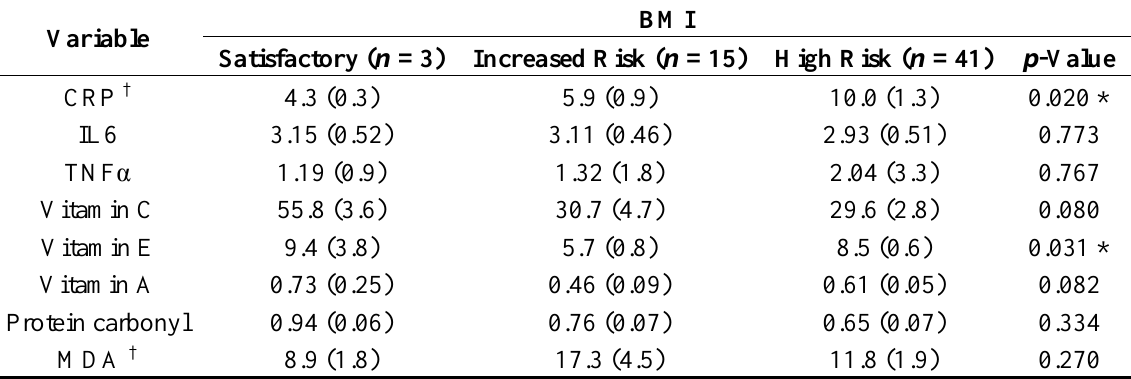
Table 3. Antioxidants and markers of oxidative damage and inflammation according to the WHO BMI cut-off-points for female subjects.